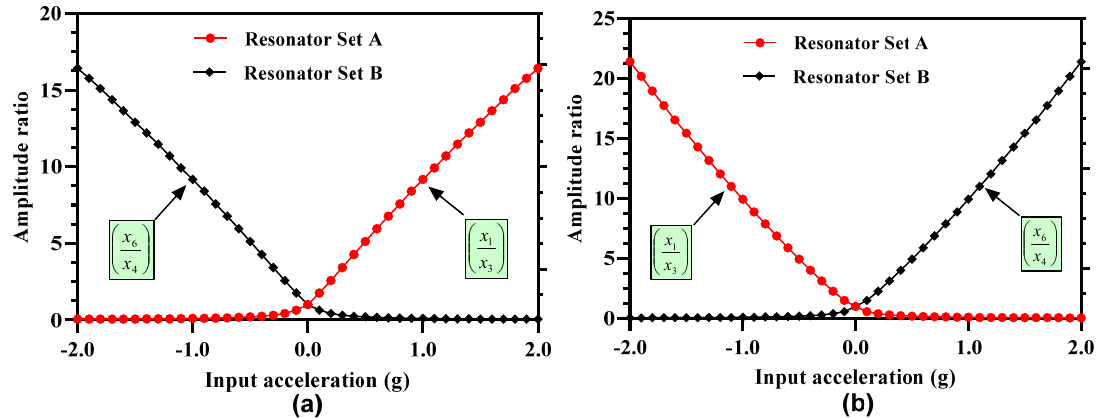
Figure 7. Amplitude ratio of the outer and inner resonators in 3-DoF resonators Set A and Set B ( a ) in-phase mode fre- quency ( b ) out-of-phase mode frequency.